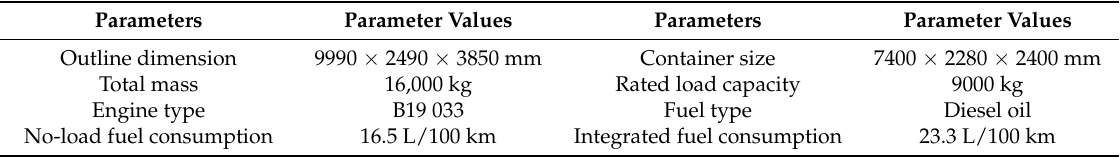
Table 4. Vehicle parameters.